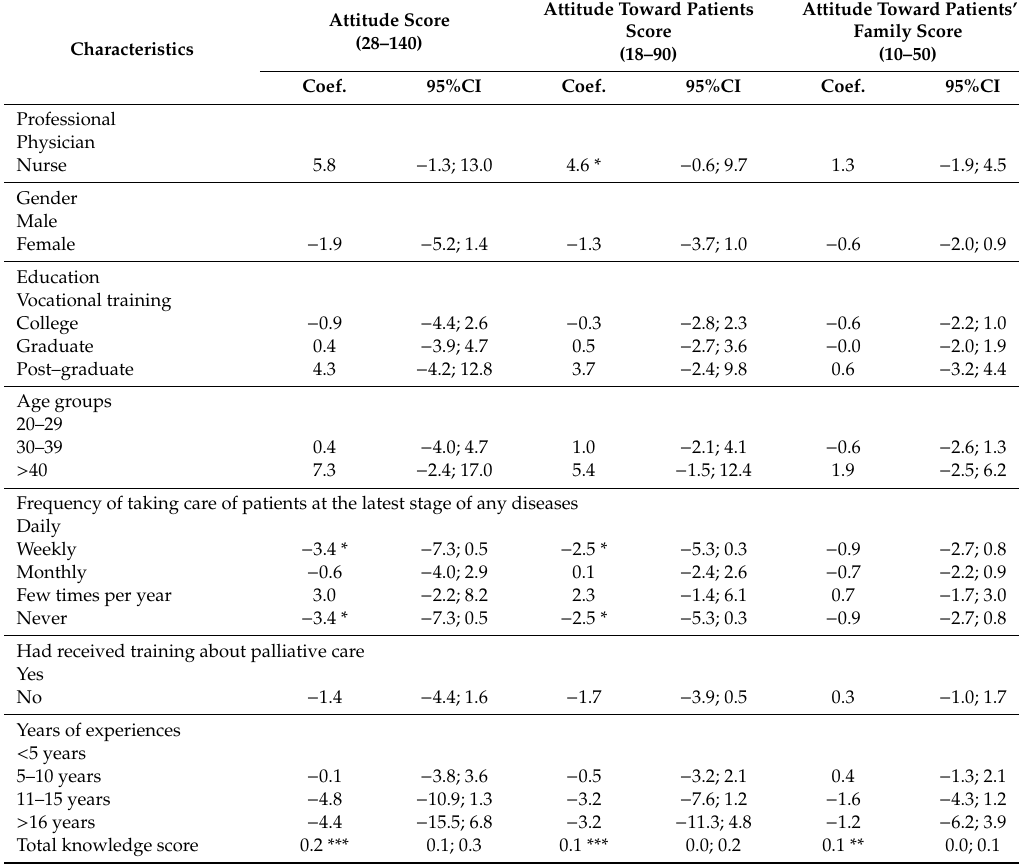
Table 5. Associated factors with attitude toward palliative